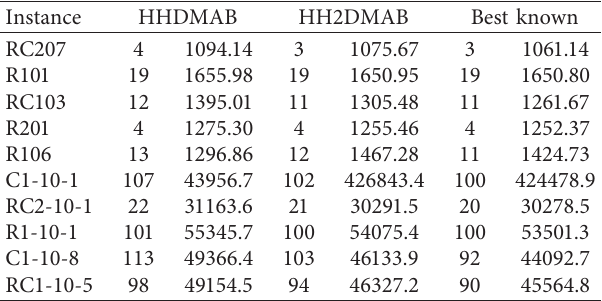
Table 7: Comparison with best-known solutions as reported in SINTEF